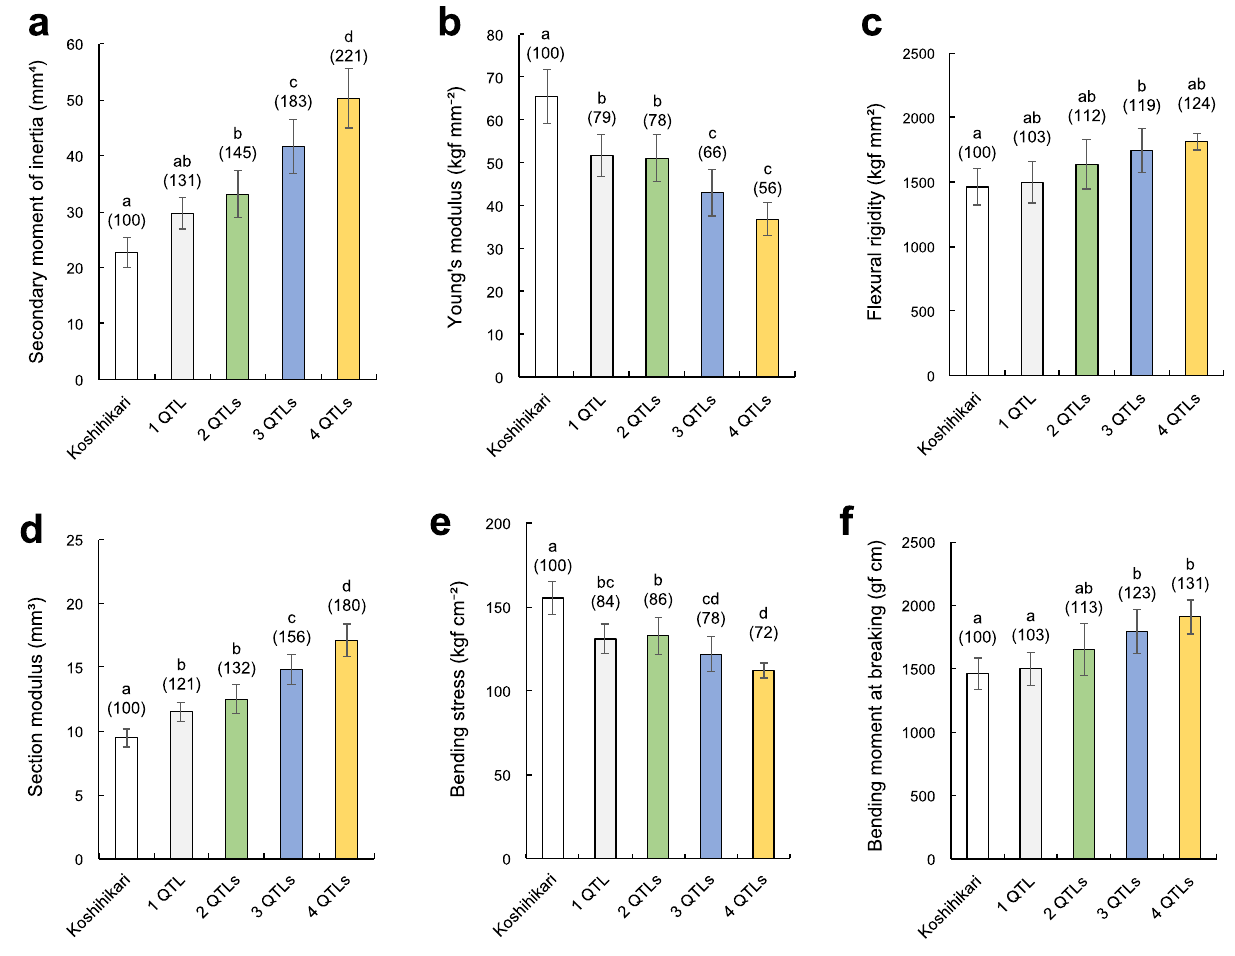
Figure 2. Comparison of strong-culm traits related to lodging resistance by number of QTL pyramiding. ( a – c ) Comparison of bending-type lodging resistance-related traits. ( a ) Secondary moment of inertia. ( b ) Young’s modulus. ( c ) Flexural rigidity. ( d – f ) Comparison of breaking-type lodging resistance-related traits. ( d ) Section modulus. ( e ) Bending stress. ( f ) Bending moment at breaking. Each column shows mean ± SD of three replicates. Different letters indicate significant differences between lines at the 5% level (Tukey’s test). The numbers in parentheses show values relative to Koshihikari